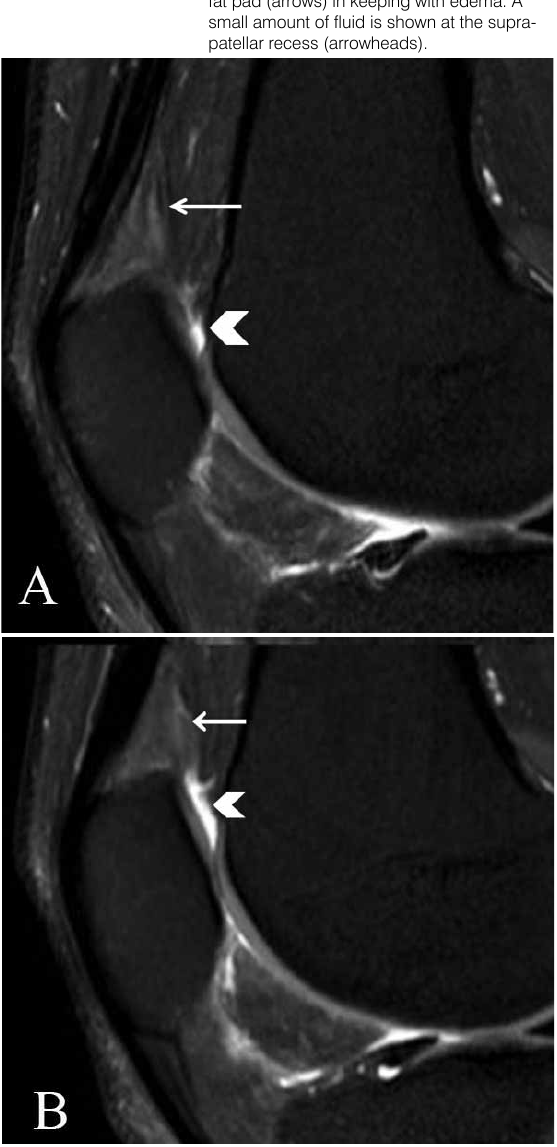
Figure 1 (a, b). A 41 year-old step female aerobic athlete with anterior knee pain. The fat suppressed PD-w (TR/TE 3500/14 ms) sagittal MR images show high MR signal intensity at the suprapatellar fat pad (arrows) in keeping with edema. A small amount of fluid is shown at the supra- patellar recess